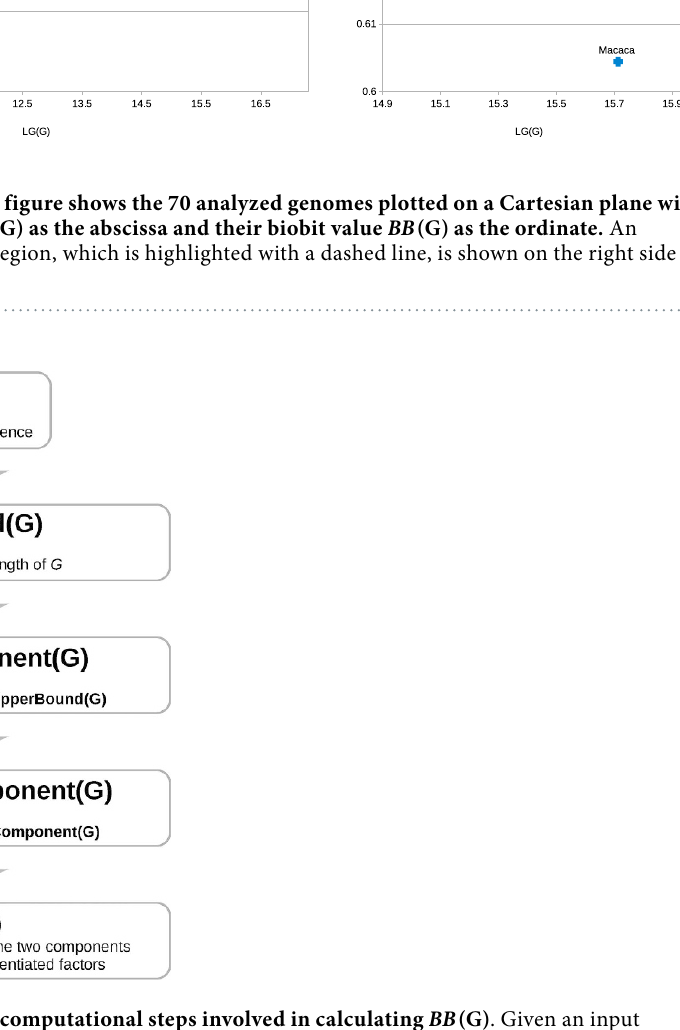
Figure 2. A flowchart of the computational steps involved in calculating BB (G) . Given an input genome  , an upper bound of maximum entropy is calculated, its value equals  LG 2 ( ) , and the value also defines the appropriate word length. Then the entropic and anti-entropic components are computed as, respectively,  EC ( ) and  AC ( ) and are successively normalized and combined by a weighted product into  BB ( )